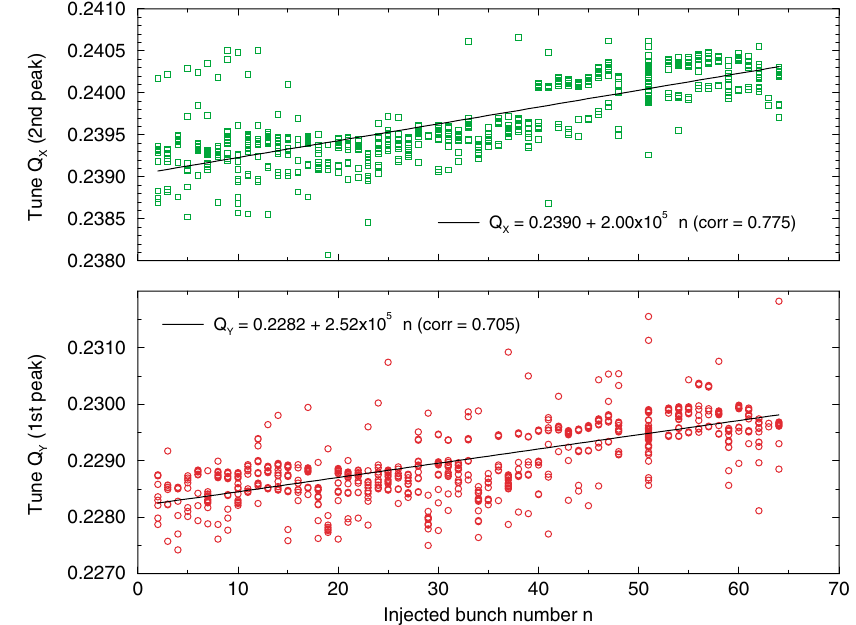
FIG. 2. (Color) Coherent tunes measured along a train of 63 gold bunches with 108 ns spacing in the Blue ring. Individual dots correspond to the tunes from different BPMs. The solid lines are linear fits to the data.